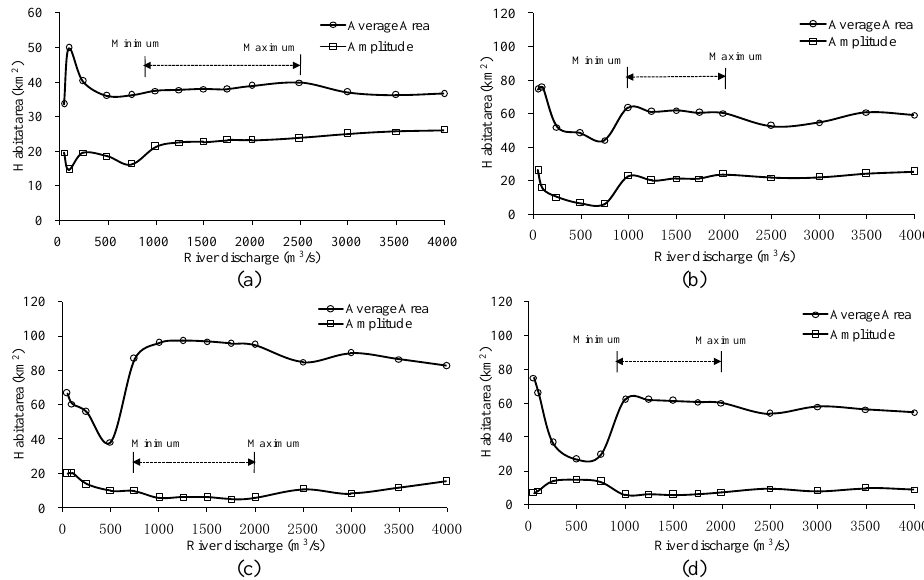
Fig. 4. Changes in habitat area with changes in freshwater inflows. (a) Chinese shrimp; (b) ridgetail prawn; (c) Chinese mitten crab; (d) jel- lyfish. Table 2. Environmental flows in the Yellow River estuary.